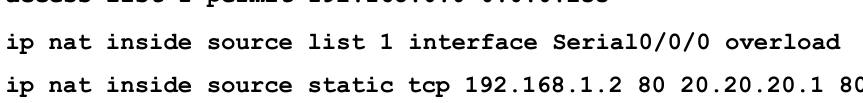
Figure 4. NAT/PAT configuration for the home network.